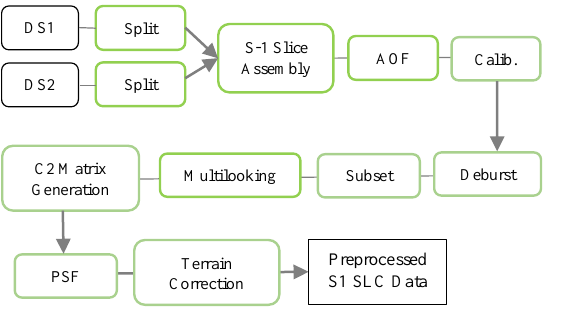
Figure 5. Preprocessing workflow of Sentinel-1 SLC products